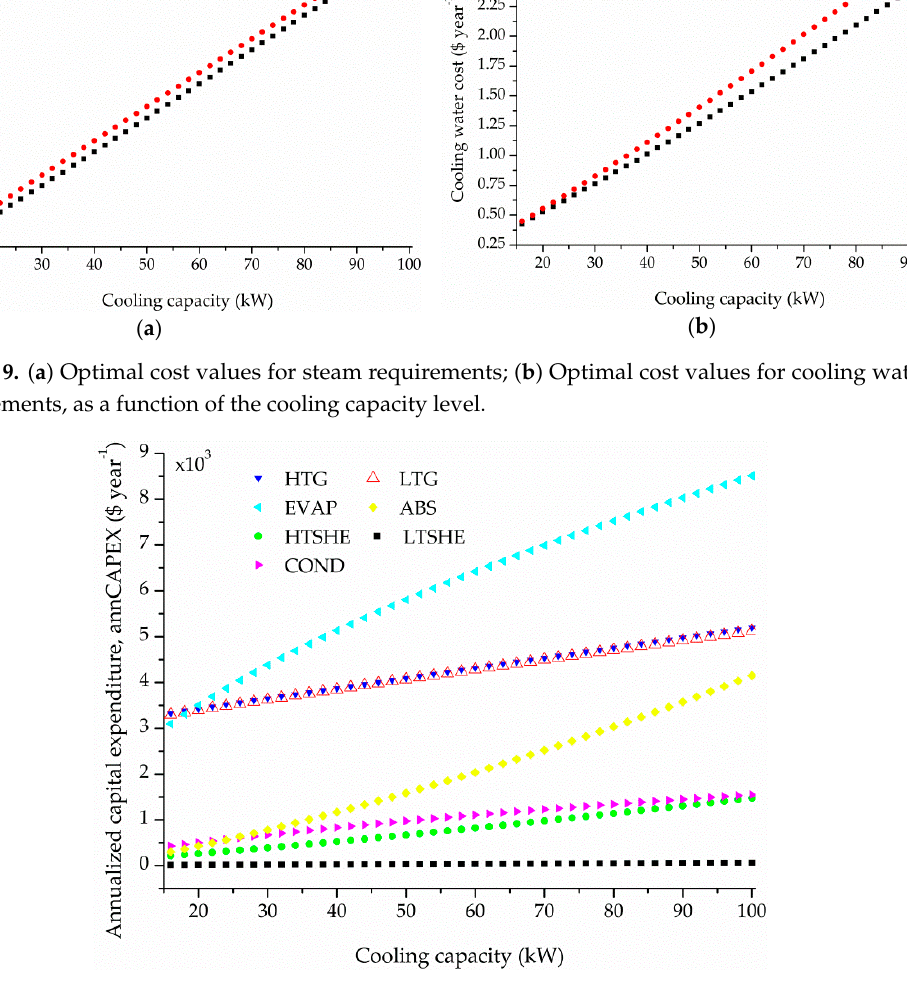
Figure 10. Optimal annualized capital expenditure (annCAPEX) values for each process unit in configuration Conf. 2 as a function of the cooling capacity level.